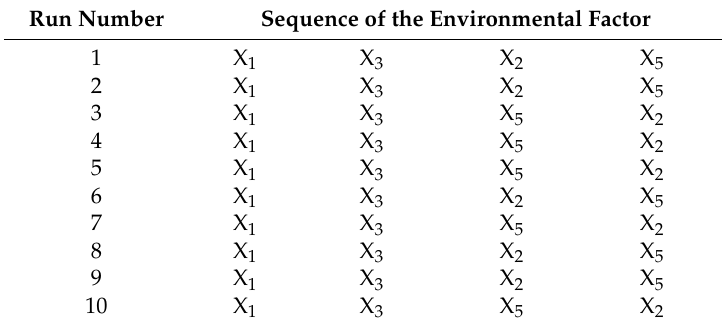
Table 4. The sequence of the significance of the factors in the SCA tree. Run